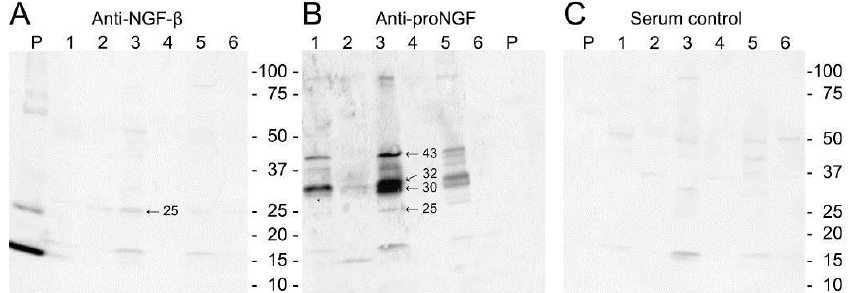
Figure 1. Western blotting of unstimulated whole saliva taken from six volunteers (lanes 1–6) and recombinant human nerve growth factor beta (NGF) (P) with antibodies reactive with ( A ) mature NGF or ( B ) pro-nerve growth factor (pro-NGF); ( C ) Control blot where primary antibody was substituted with normal rabbit serum. With permission from ref. [7].